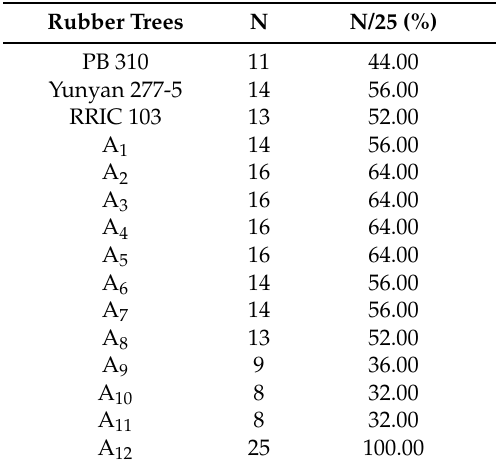
Table 4. Number of SSR markers showing every possible male parent for Tri-1.